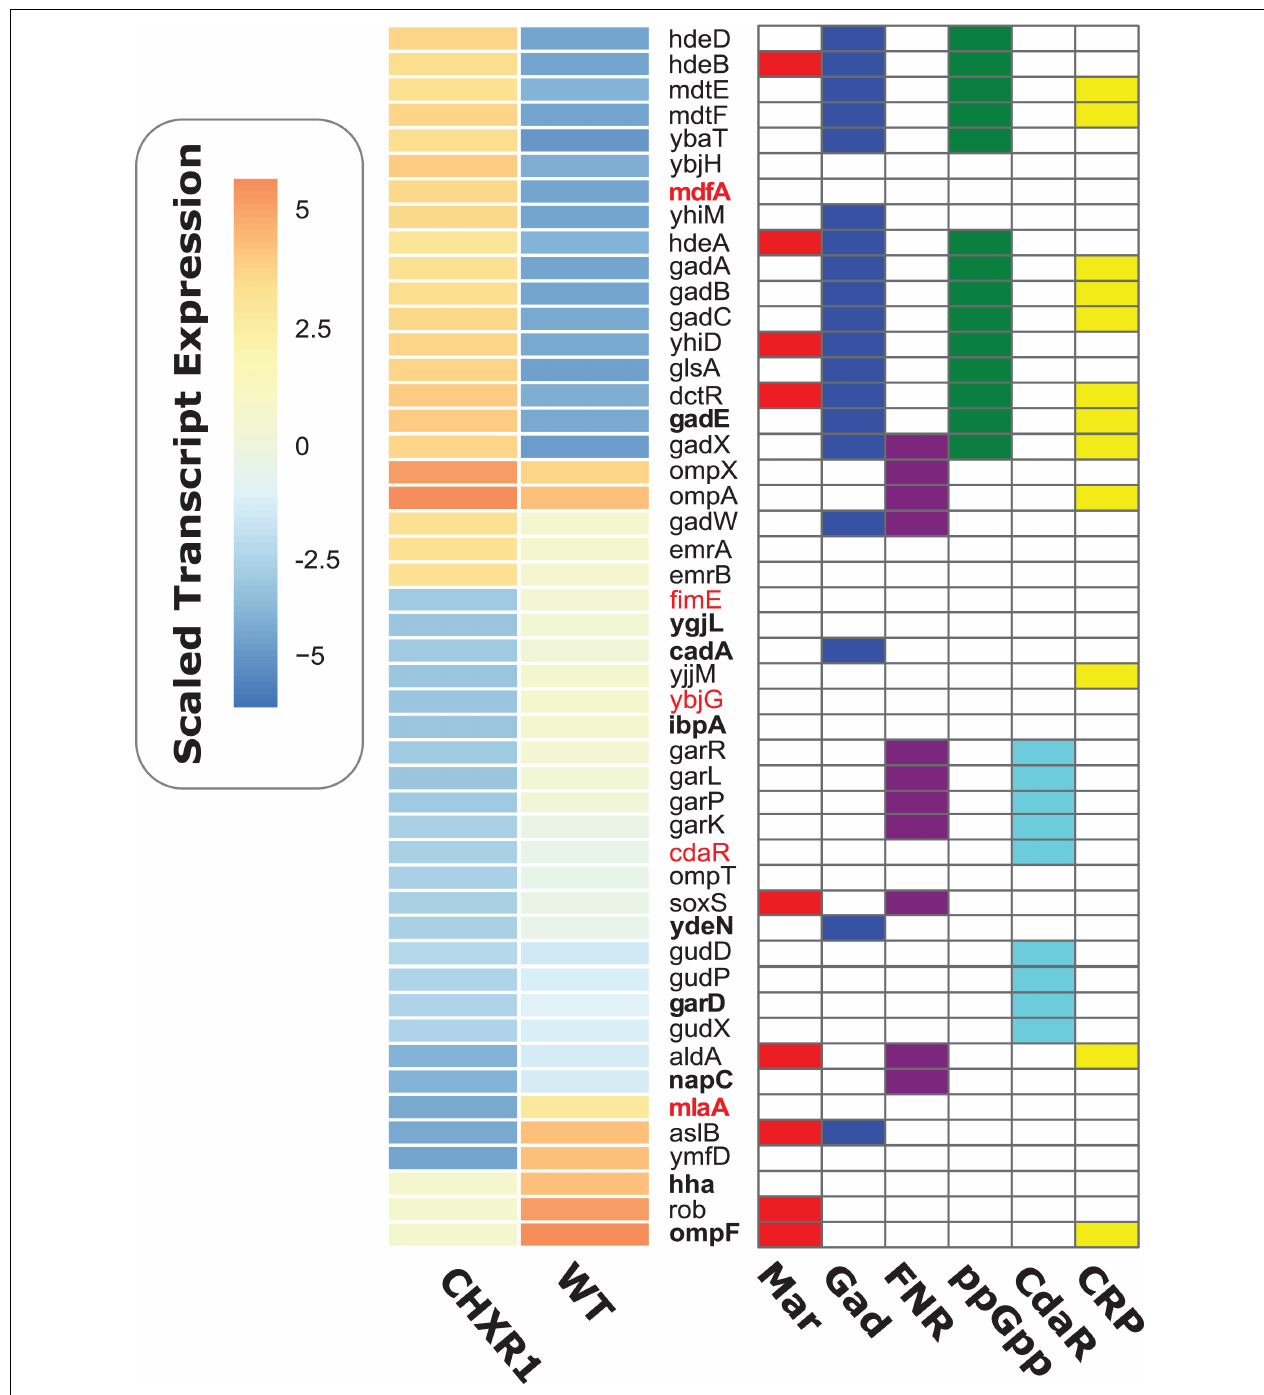
FIGURE 4 | A heatmap diagram of significantly altered gene transcripts of CHXR1 and WT E. coli for RNA-seq transcriptional analysis. The heatmap shown to the left of the gene names listed indicates scaled median gene expression values of CHXR1 and WT, where red to orange colors indicate genes that were up-regulated and blue to dark blue colors indicate down-regulated transcripts of CHXR1 to WT. Heat mapped expression data represents median gene expression values from three biological replicates ( n = 3) of WT and CHXR1 isolates. Colored charts on the right-hand grid beside each y -axis gene name indicate whether or not the listed gene is regulated by the mar-sox-rob regulon (Mar; red), GadE/W/X (Gad; blue), fumarate and nitrate reductase regulon (FNR; purple), stringent response system (ppGpp; green), carbohydrate diacid regulator CdaR (light blue), and cyclic AMP-CRP regulon (CRP; yellow). Gene names in red font indicate genes that possessed SNVs ( Figure 5B and Table 4 ) and genes with bolded font indicate translated protein products that were significantly altered in abundance based on proteomic analyses ( Figure 3 ).